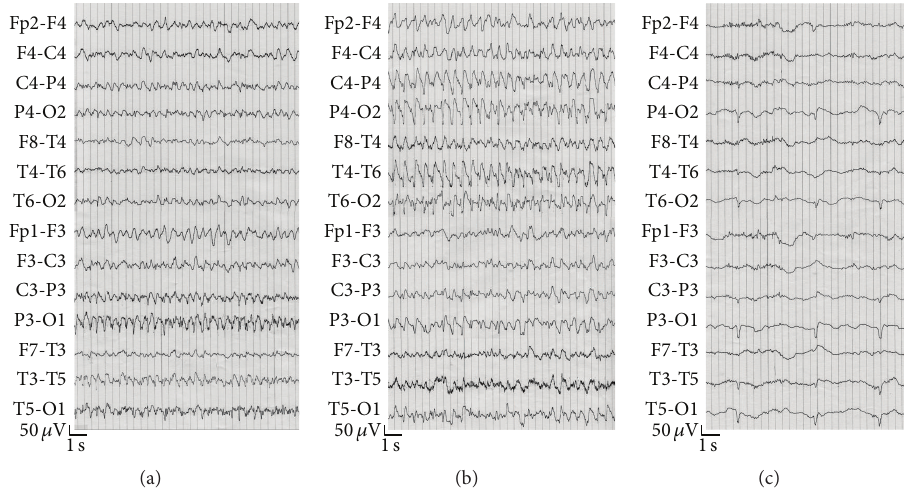
Figure 1: Independent seizure activity in the posterior cerebral regions. (a) Epileptic abnormalities in the left occipital area. (b) Rhythmic sharp waves in the right temporoparietooccipital regions. Leftward deviation of the head and oculoclonic movements were noted during the discharge. (c) Persistence of periodic sharp waves in both occipital regions after cessation of SE.